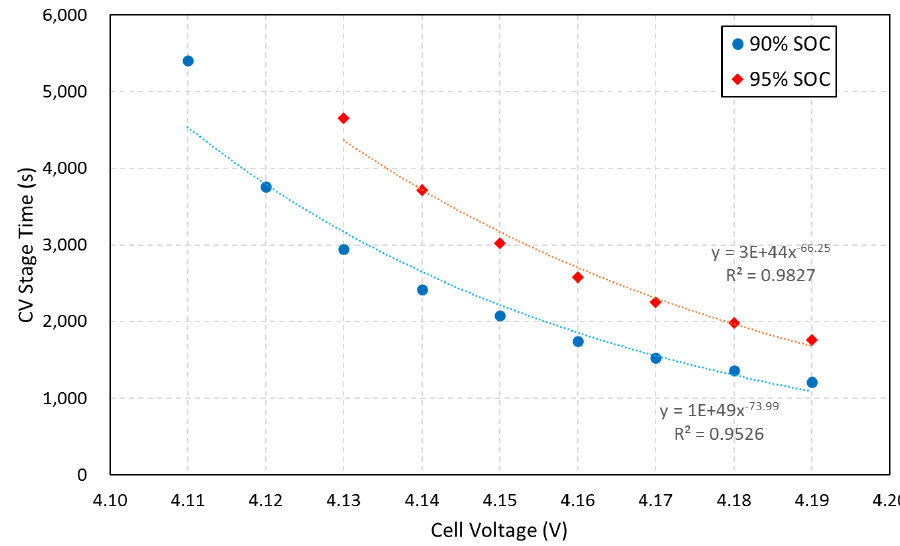
Figure 11. Necessary CV stage time at different cut-off voltage values to reach 90% and 95% SOC